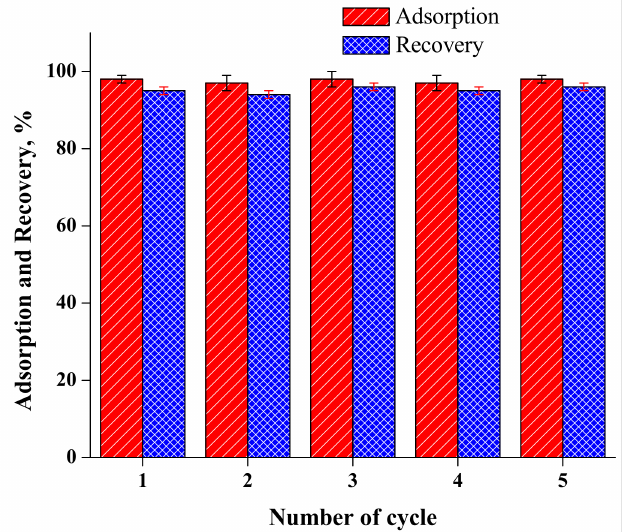
Figure 9. Recycling of MNPs/rGO/PMMA composite; eluent, 2M NaOH solution; volume, 30